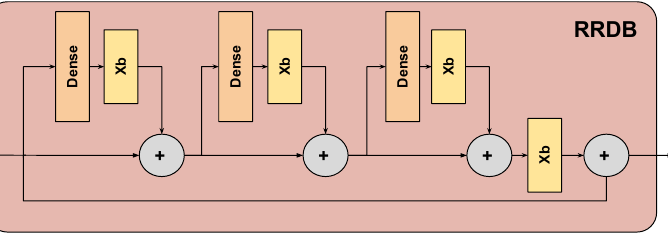
Figure 2. Residual in Residual Dense Block (RRDB). Each 2D convolutional layer has 32 feature maps, a 3 × 3 kernel with stride of 1.